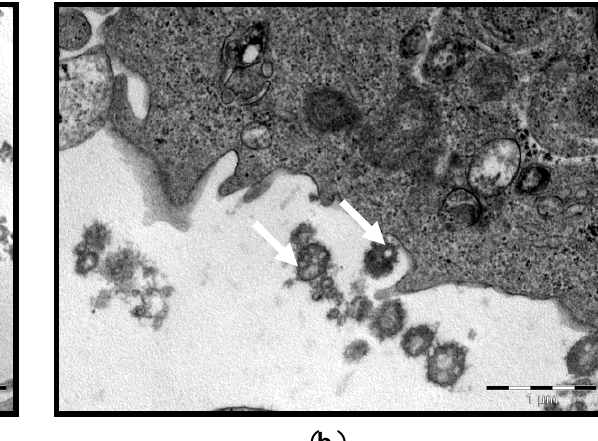
Figure 2. TEM of ENP uptake by the human THP-1 cell line. Monocytes were exposed to 200 µg/mL for 2 h; the arrows indicate ( a ) internal; ( b ) external nanoparticles; and ( c ) that no changes were observed in the cell structure after 24